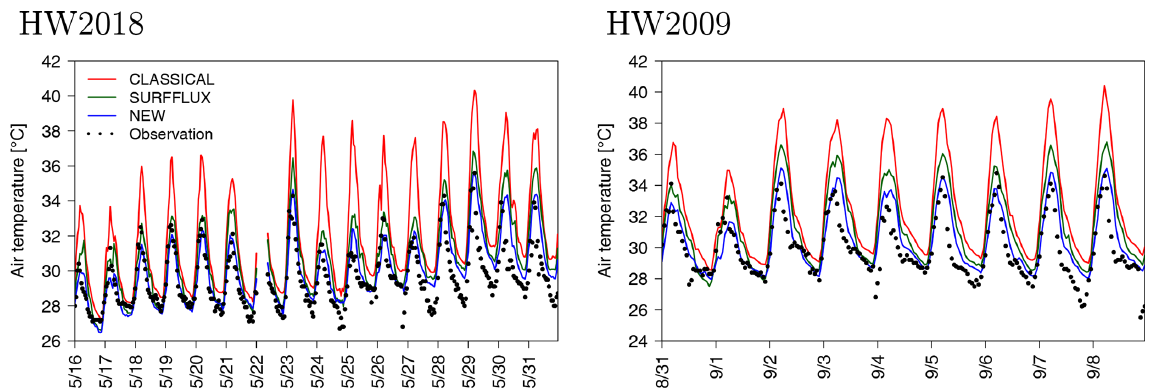
Figure 7. Time series (UTC) of simulated (D4) and observed near-surface air temperature at the HKP station.